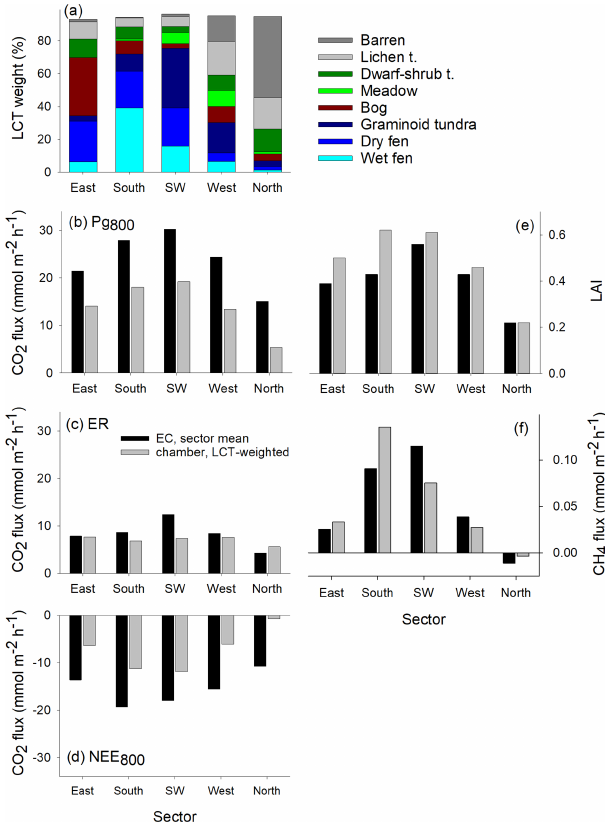
Figure 7. Footprint-weighted mean contribution of each LCT to the EC measurements divided into wind direction sectors (a) , and com- parison of EC and chamber-based sector means of CO 2 exchange (Pg 800 , ER, and NEE 800 ) (b–d) vascular plant LAI (e) , and CH 4 fluxes (f) . The chamber-based data are weighted by the LCT pro- portions shown in panel a. All data were measured in 2014. Map of LAI (Tuovinen et al., 2019) and the LAI measured in the collars were used to estimate the EC – and chamber – related sector means, respectively, in panel (e)